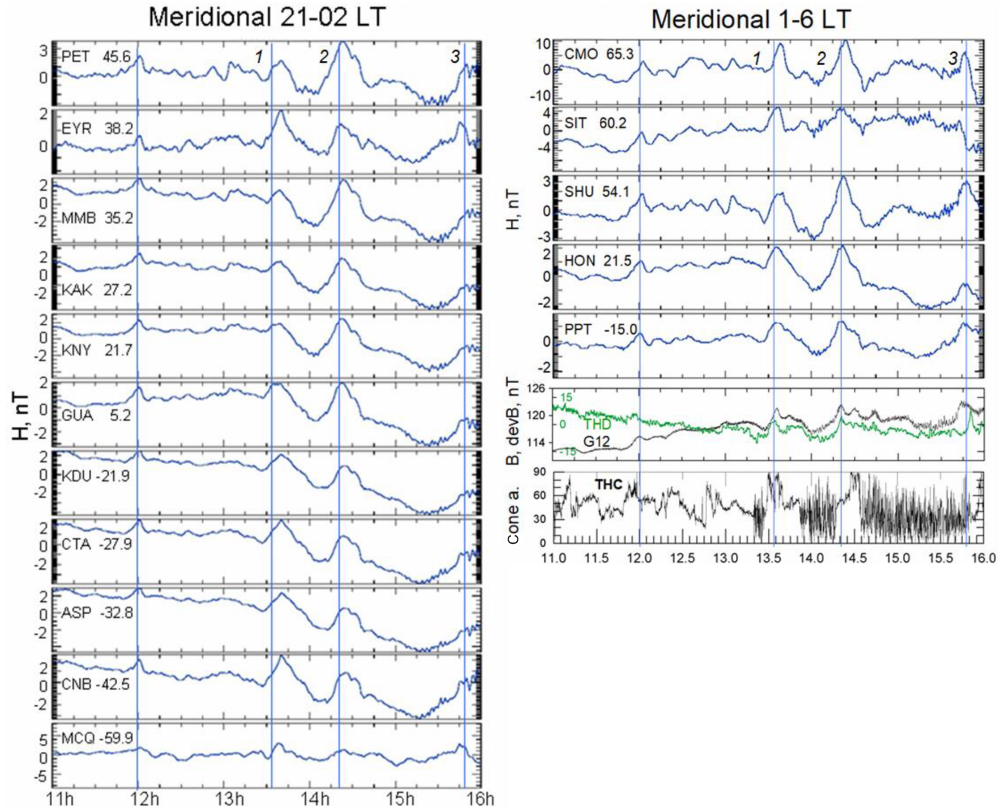
Figure 10. Relative variations in the horizontal component ( H ) of the geomagnetic field in the midnight (left) and predawn (right) sectors. The geomagnetic latitudes of the stations are indicated near station codes. The vertical lines depict magnetic peaks at THEMIS (see Table 2). Magnetic data from the THEMIS and GOES satellites are shown in the lower panels on the